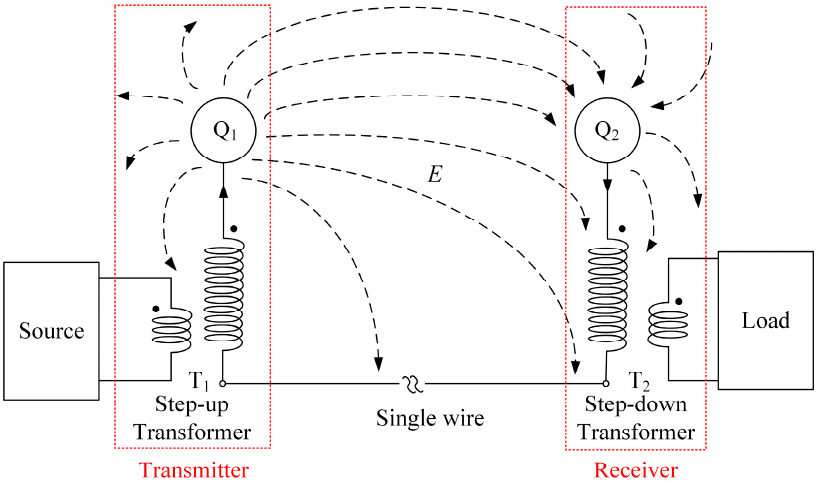
Figure 1. The circuit diagram of the single-wire ECPT system.